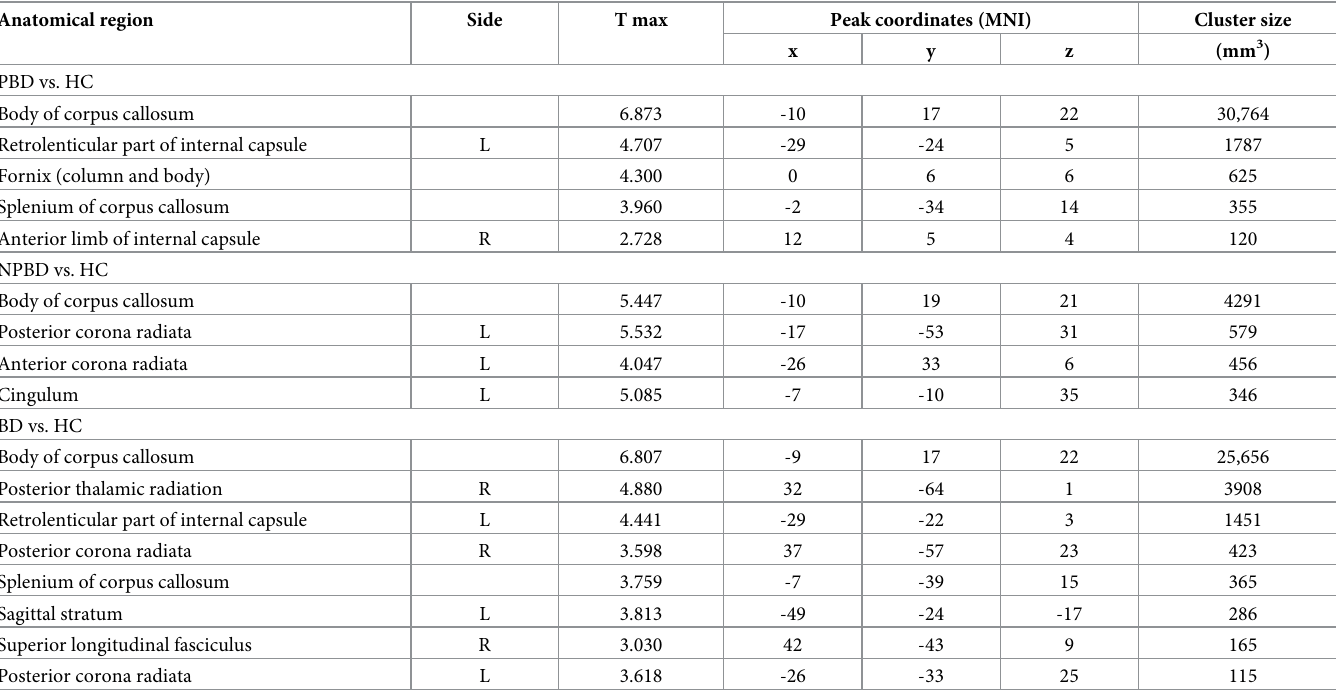
Table 2. Comparisons of fractional anisotropy among PBD (N = 29), NPBD (N = 23), BD (PBD + NPBD) (N = 52), and HC (N = 65) groups a . Anatomical